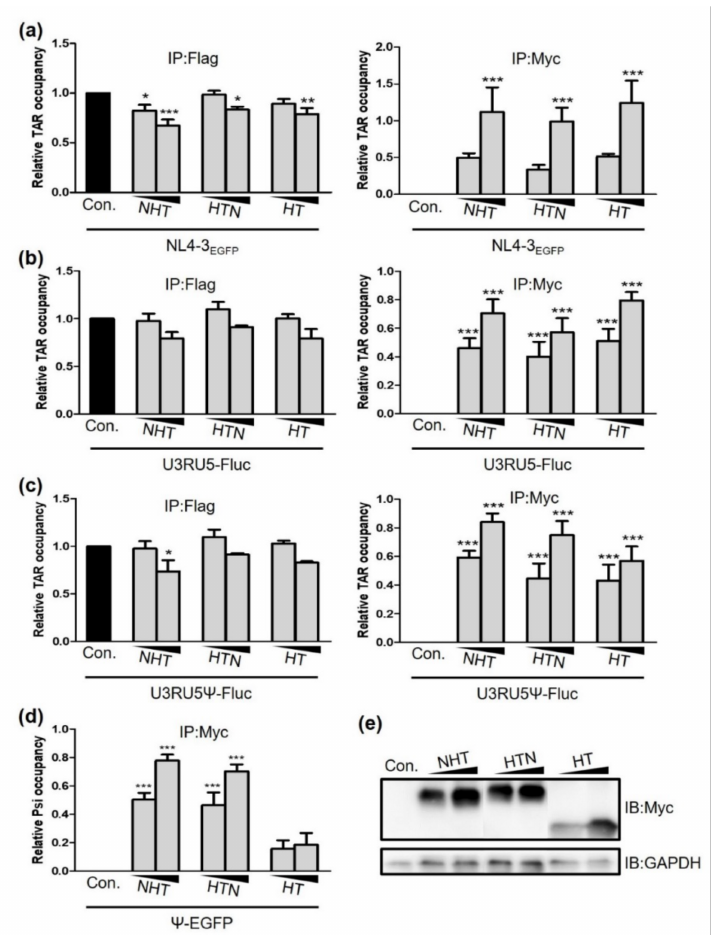
Figure 5. NHT, HTN, and HT interact with viral RNA. HEK293T cells were transfected with the empty vector; Myc-tagged NHT, HTN, or HT, or Flag-tagged Tat with NL4-3EGFP ( a ), U3RU5-Fluc ( b ), U3RU5 Ψ -Fluc ( c ) or Ψ -EGFP ( d ). Twenty-four hours after transfection, cells were lysed in passive lysis buffer, and each cell lysate was pulled down by Myc or Flag antibody. RT-PCR was performed using primers complementary to TAR or Ψ to measure the amount of viral RNA bound to each chimeric protein or Tat. In the “IP: Myc” graphs, each value was obtained by subtracting the amount of vRNA bound non-specifically in the control group from the raw data. ( e ) Expression of NHT, HTN, and HT. Statistical significance was assessed using one-way ANOVA (* p < 0.05, ** p < 0.01, *** p < 0.005). TAR, transactivation response